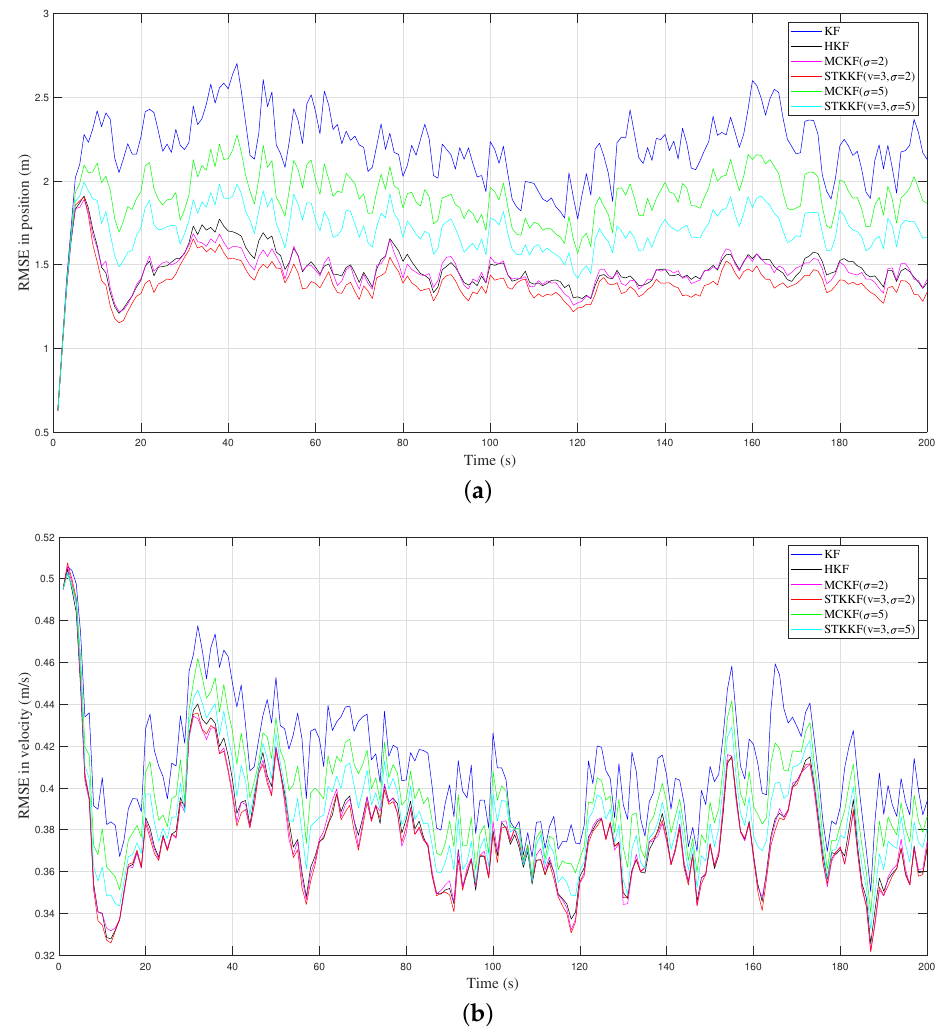
Figure 2. RMSE results of different filters in case 2 where RMSE is taken over 100 Monte Carlo simulations: ( a ) position. ( b )